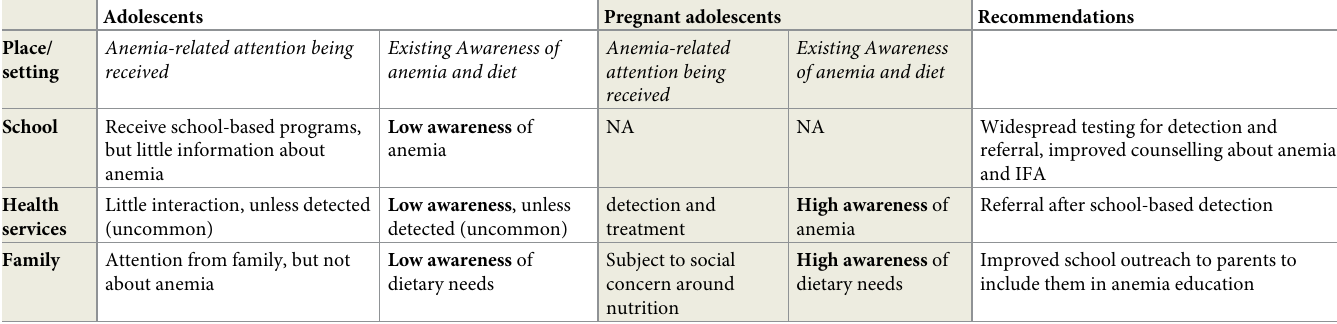
Table 3. Findings and